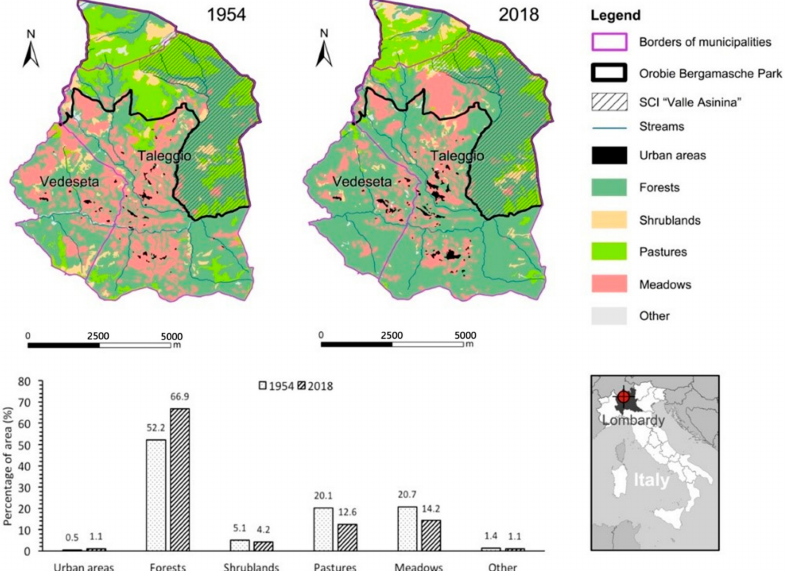
Figure1. Geographiclocationofthestudyarea(TaleggioValley)andland-usechangesfrom1954 to 2018 (data source: [33]). Orobie Bergamasche Regional Park was created in